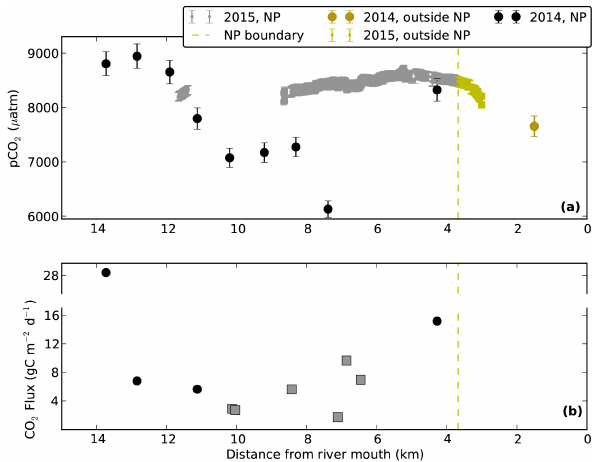
Figure 4. p CO 2 (a) and CO 2 fluxes (b) as measured along the spatial extent of the Maludam River. Flow direction is from left to right. The gap in the 2015 data is due to a failure in data storage. Note the discontinuous vertical axis in (b) . The legend applies to both panels.